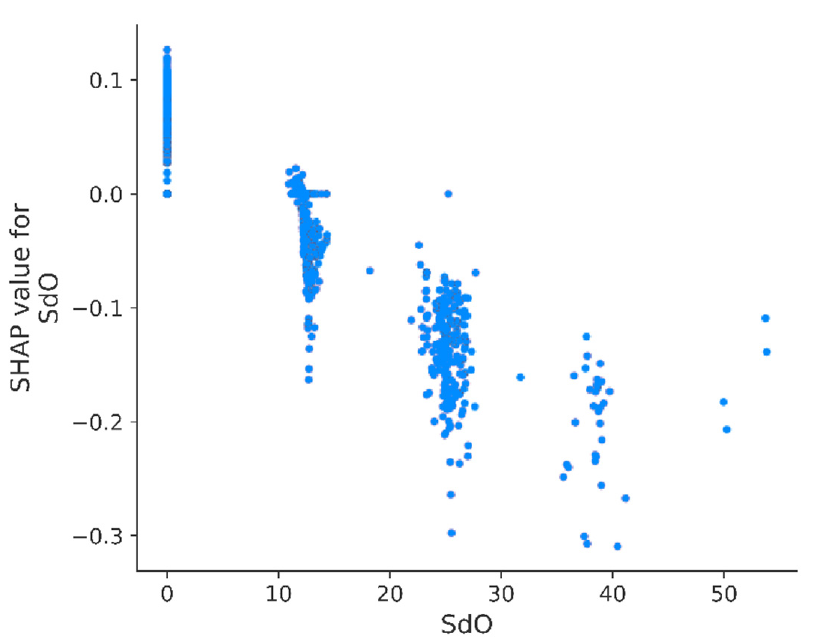
Figure 12. Calculated SHAP values for individual records as a function of SdO descriptor value. In the case of JGI4, representing the topological charge of the molecule and measuring the charge transfers between atom pairs [51], it was observed that values below 0.035 were associated with an increased value of pKi predicted by the model. On the other hand, JGI4 values above 0.035 decreased the predicted value of pKi (Figure 13). Moreover, there was a visible trend suggesting a functional relationship of pKi and JGI4. According to Nowaczyk and Kulig, a decrease in the JGI4 value is observed in molecules which have unevenly distributed electrostatic charge. In other words, JGI4 value is lower for unsubstituted compounds than for compounds substituted with groups of high electrostatic charge (– OH, –O–CH 3 , and –Cl). Therefore, in order to increase pKi value, it suggests the need for a unique charge distribution of the chemical compound [52]. This finding additionally supports the structure of the 5-HT1A receptor suggested by Zlatovi´c et al., in which an acidic amino acid (Asp 116) is located at the ligand–protein binding site